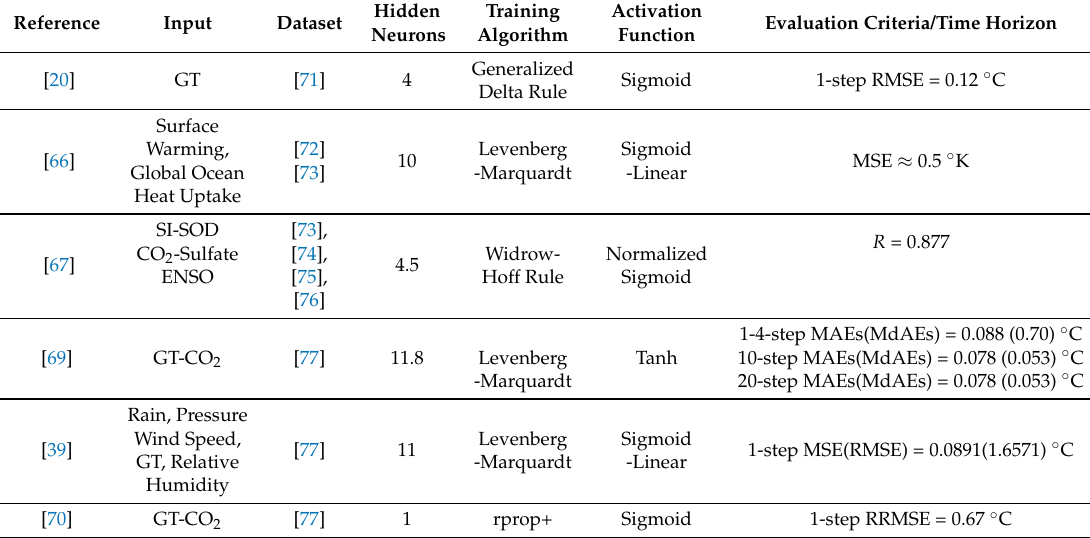
Table 1. Representative papers related to Global Surface Temperature Prediction based on